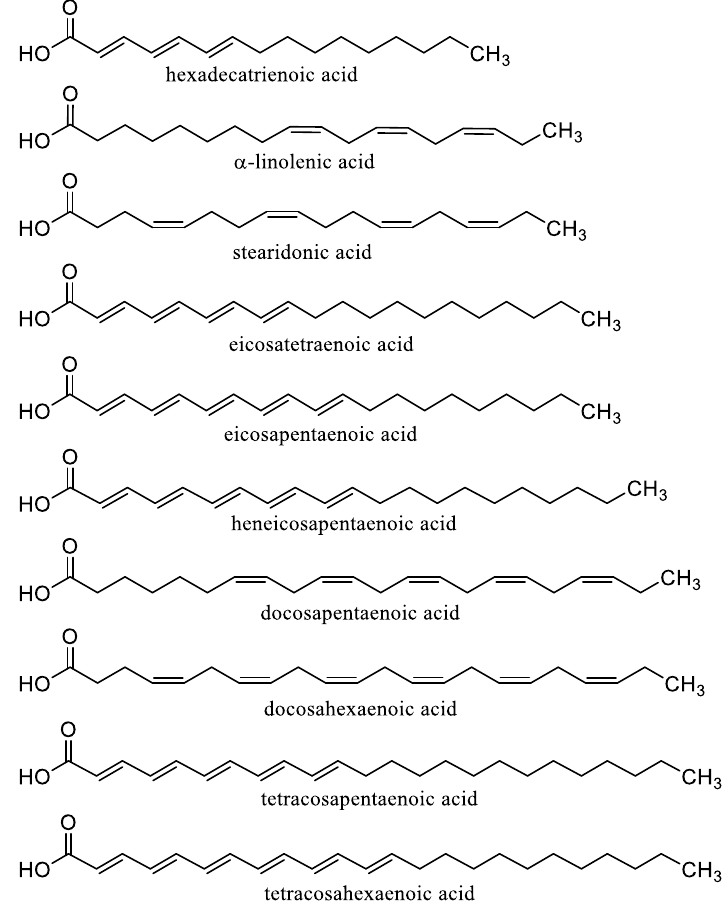
Figure 7. Structures of polyunsaturated omega-3 fatty acids.